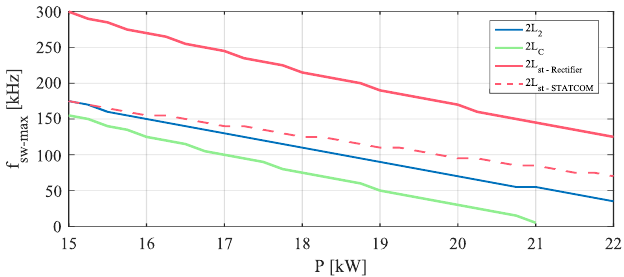
Figure 6. Thermal analysis results for the different power